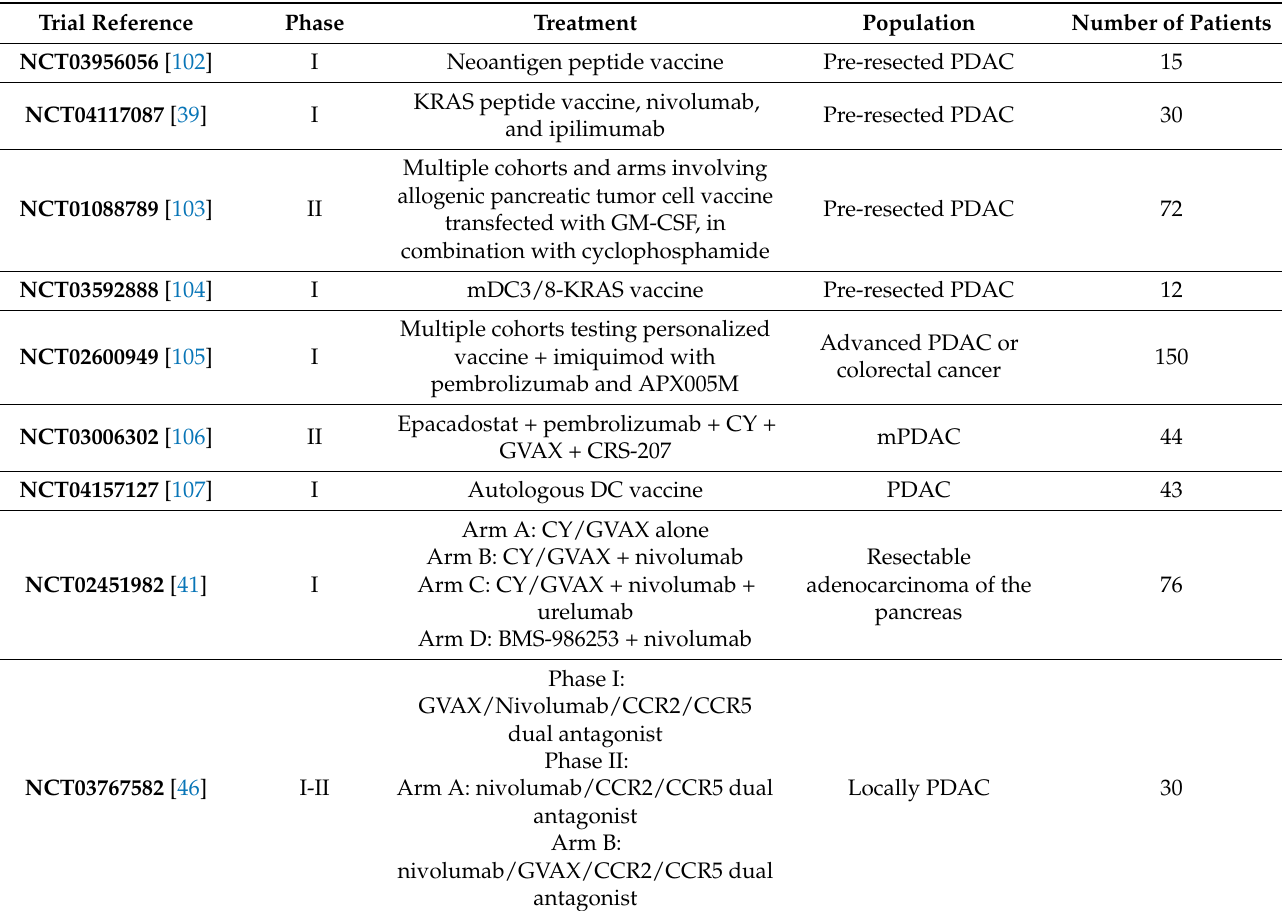
Table 4. Characteristics of ongoing vaccine trials in